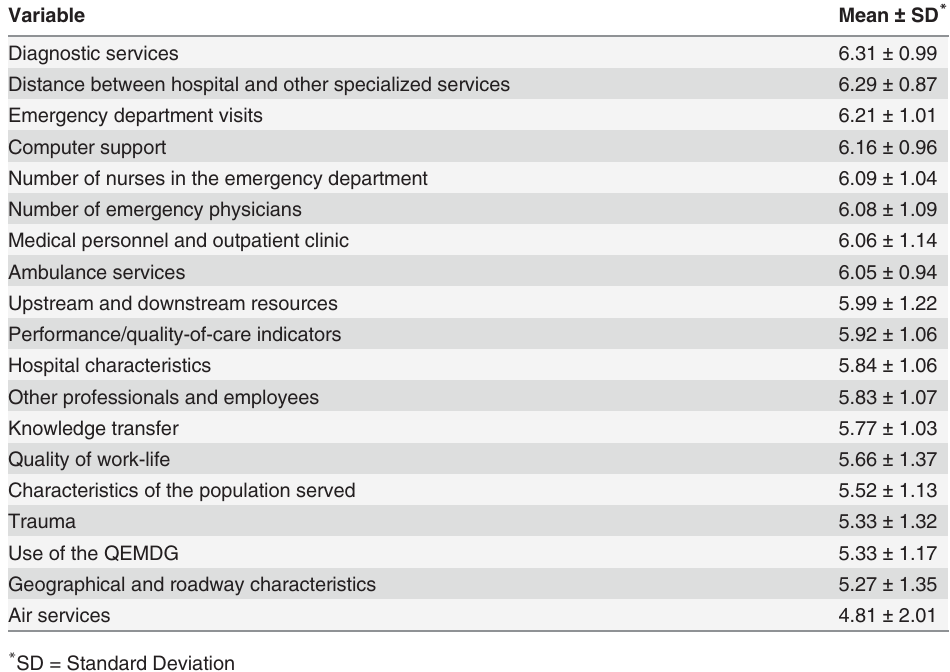
Table 1. Participant ranking (in decreasing order) of importance of study variables on a scale from 1 “ not at all useful ” to 7 “ extremely useful ”